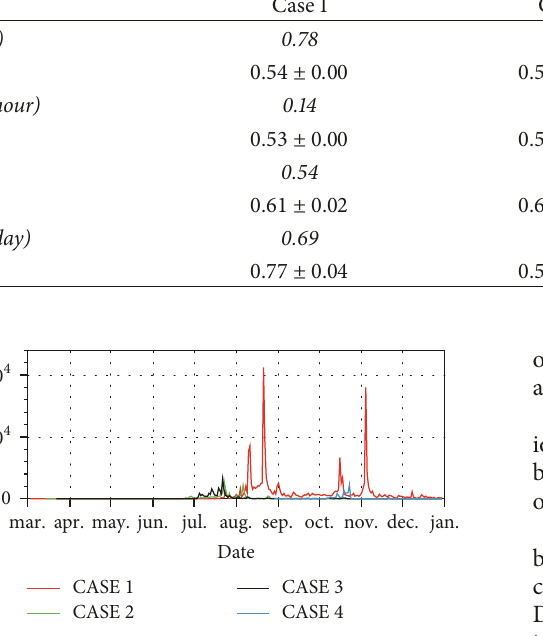
Figure 3: Daily activity (number of tweets) for the four cases